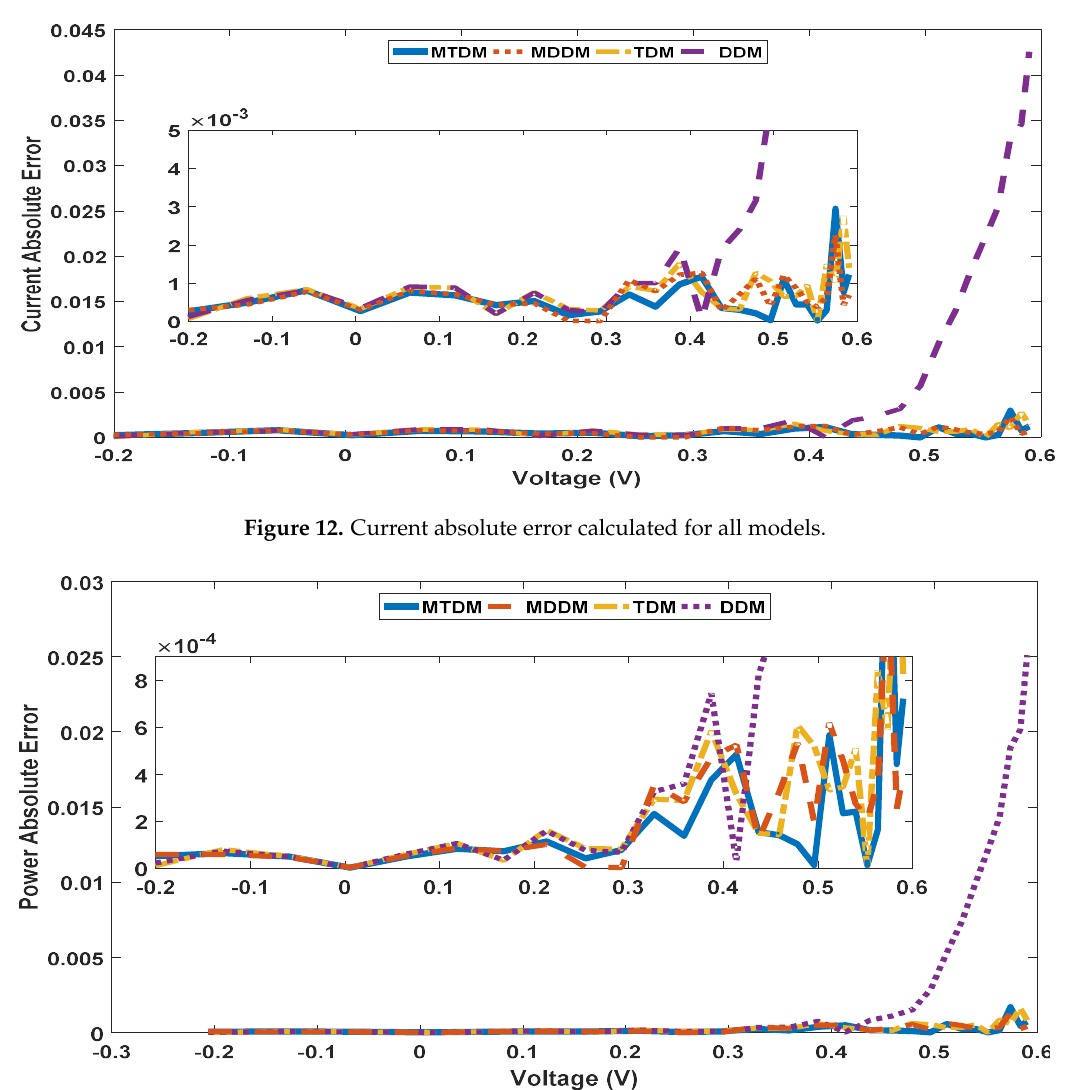
Figure 13. Power absolute error calculated for all models .